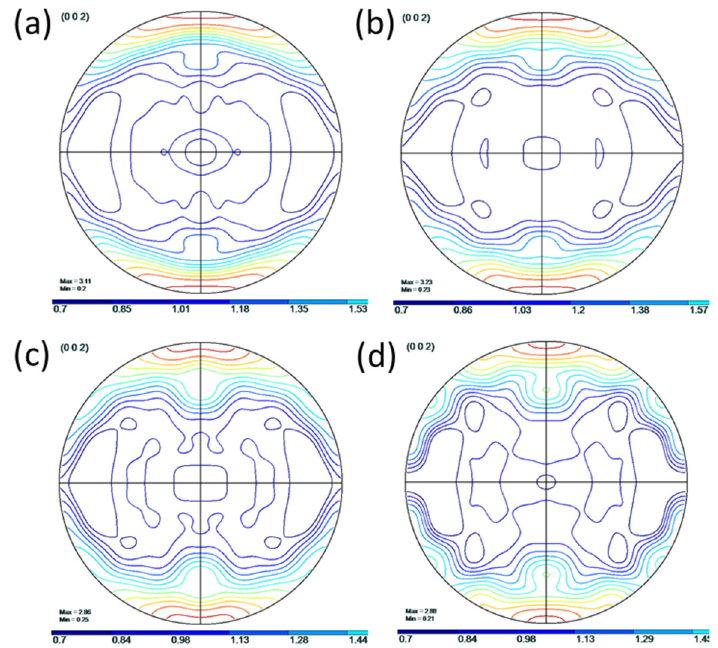
Figure 10. Macro texture of Mg-3Sn-2Al-1Zn-0.6Nd alloy under different hot deformation conditions: ( a ) 250 °C/0.01 s − 1 , ( b ) 300 °C/0.01 s − 1 , ( c ) 350 °C/0.01 s − 1 , and ( d ) 350 °C/0.001 s − 1 .